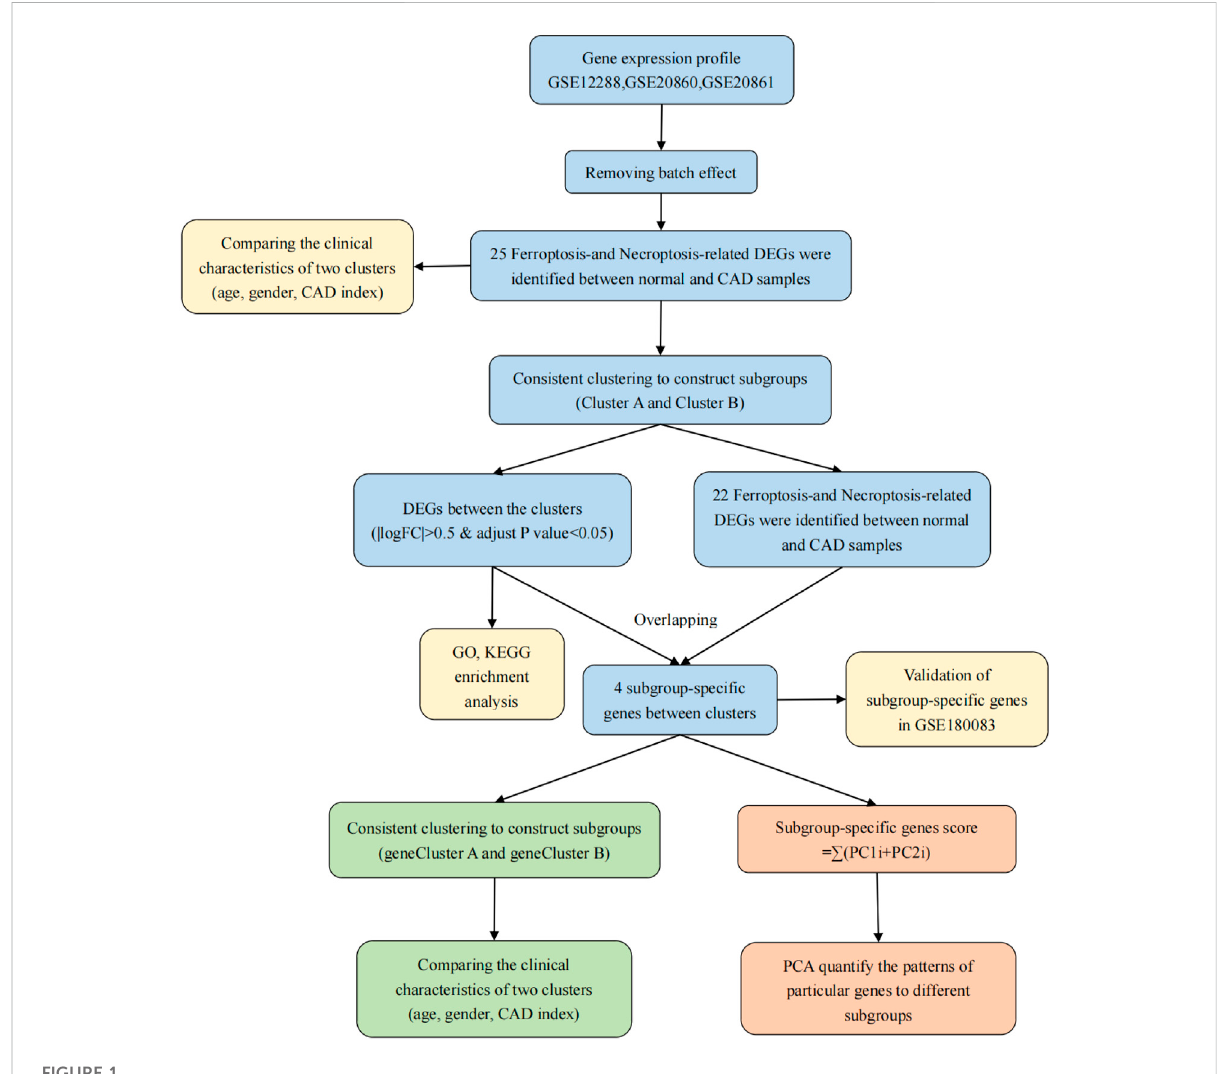
FIGURE 1 Flow chart of the research